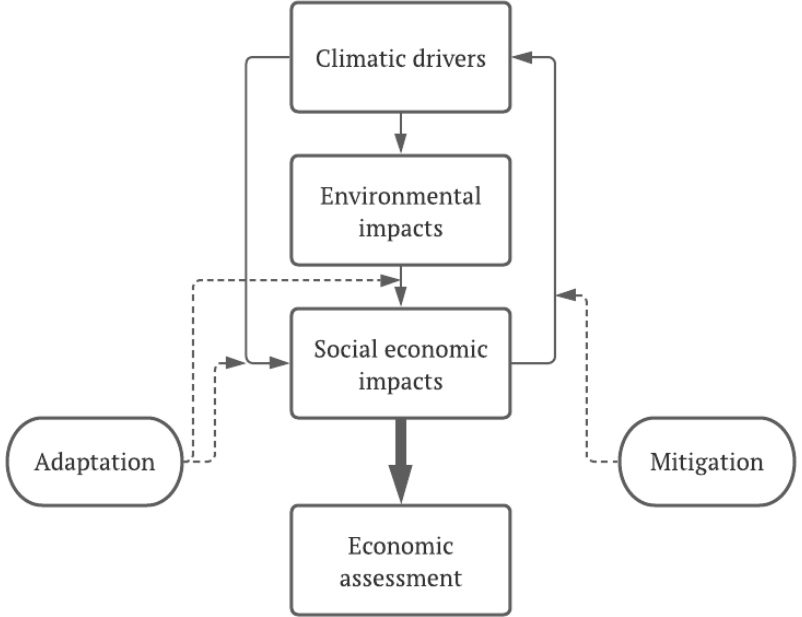
Figure 6. Socioeconomic impacts of climate change (adapted from https://www.iemed.org/publication/the-economic-impacts-of-climate-change-in-the-mediterranean/, accessed on 22 December 2021).